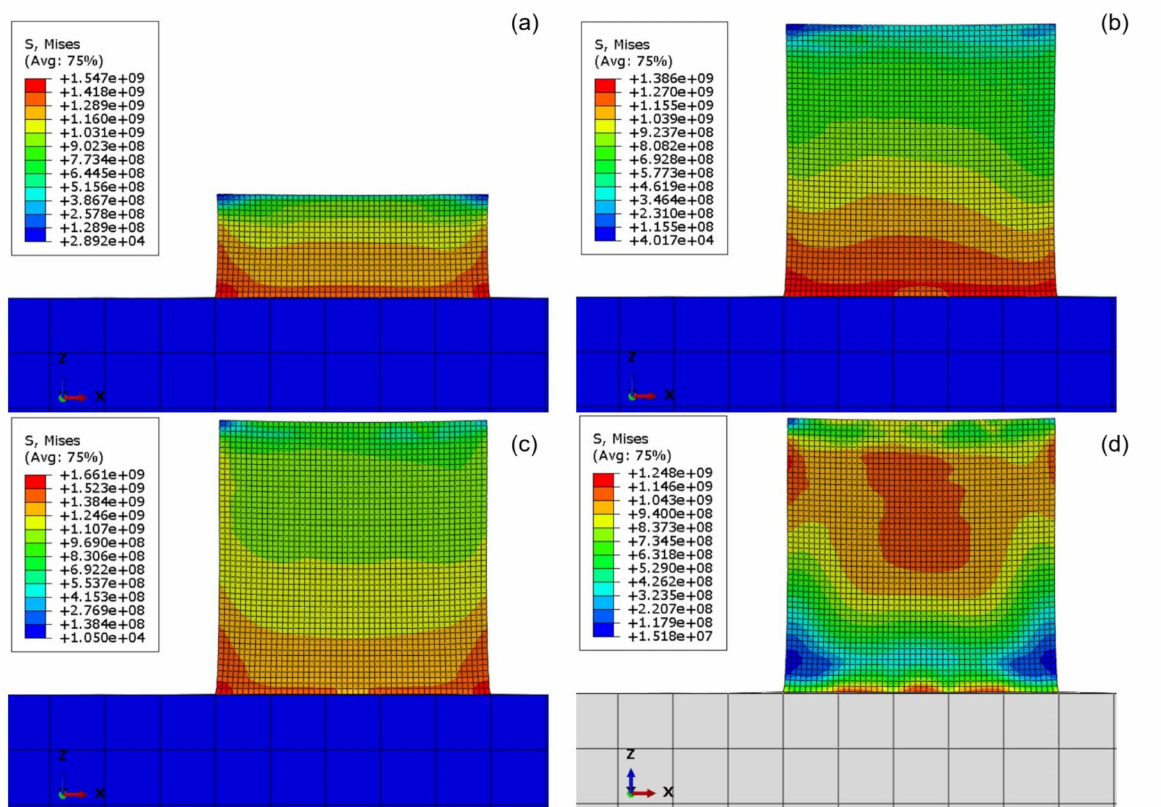
Figure 42. Evolution of the part scale Mises stress at ( a ) 667 s, ( b ) 1714 s, and ( c ) 2310 s ( d ) after separation from the build plate at 220 W, 650 mm/s, and 0.12